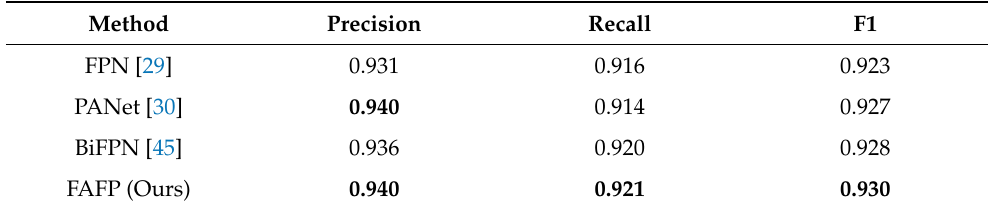
Table 3. Comparison effects of different feature fusion pyramids, in which the FEM and TRsB modules are not used in FAFP.